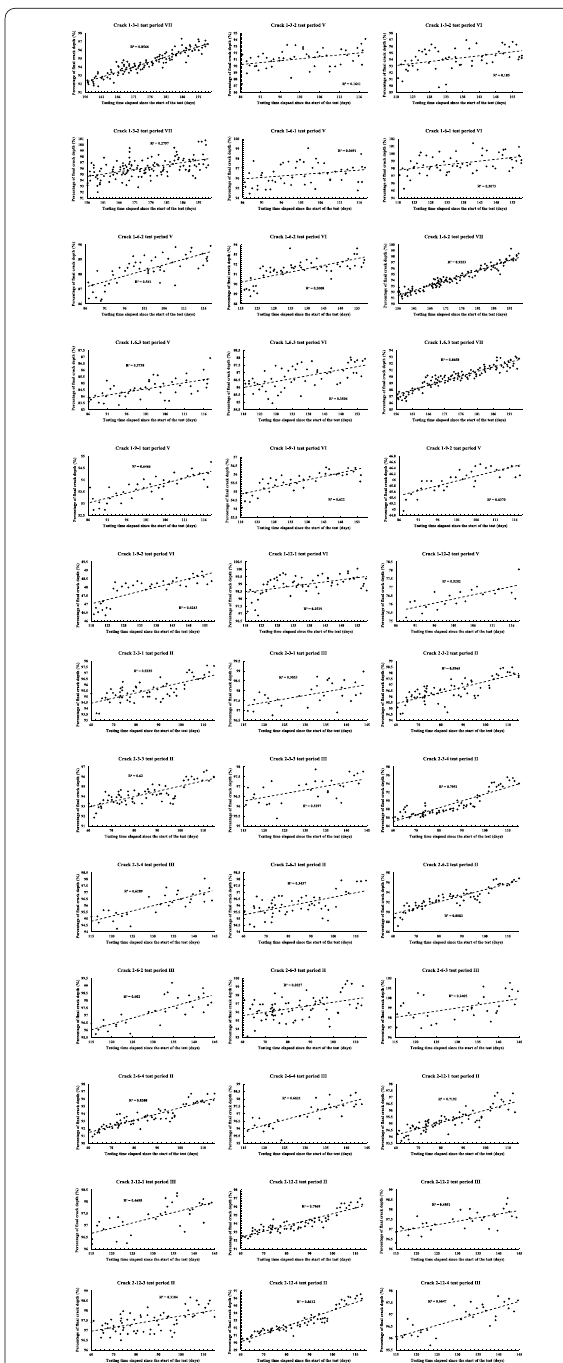
Fig. 7 1 Linear regression results corresponding to the crack growth rates in the dataset